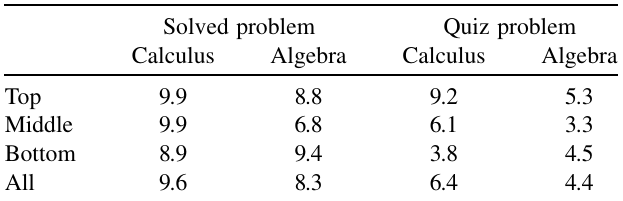
TABLE X. Students’ average scores out of 10 on the quiz (transfer) problem in the calculus-based course.